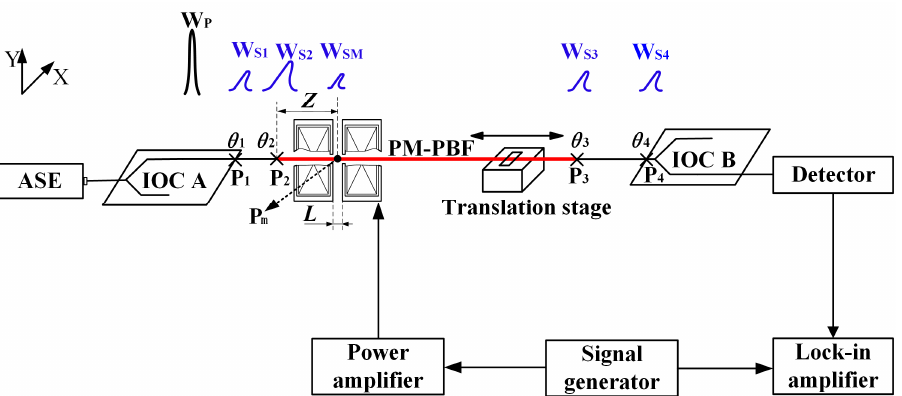
Figure 1. Schematic of the setup for measuring the Verdet constant of the polarization-maintaining air-core photonic bandgap fiber (PM-PBF). The bold red line between P 2 and P 3 is the PM-PBF.